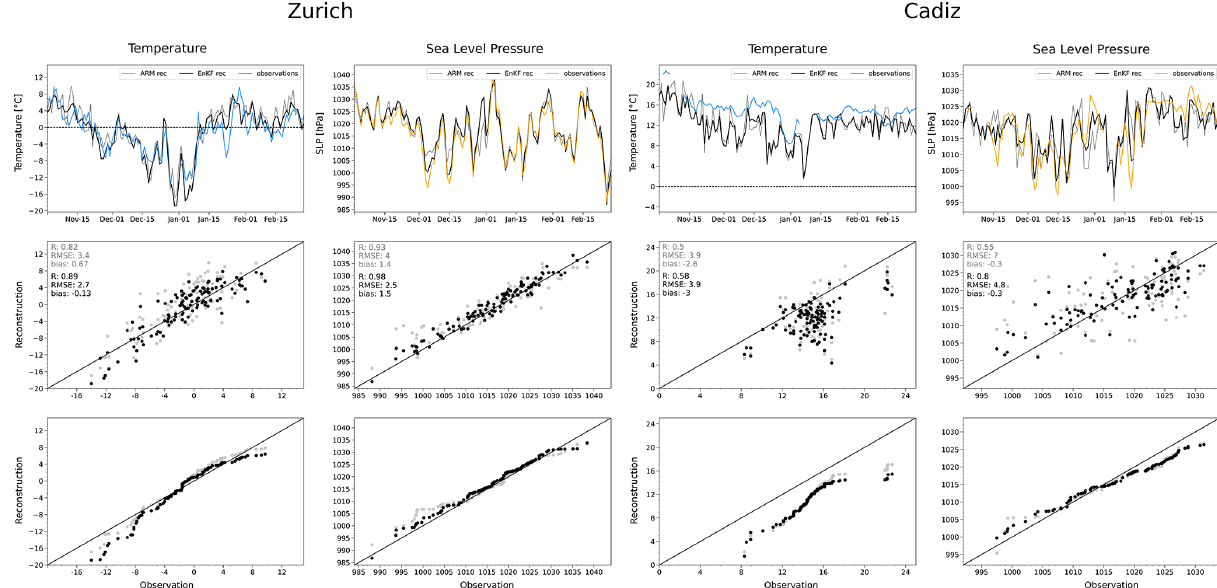
Figure 5. Validation of ARM and EnKF reconstructions of the winter 1788/89 against independent observations from Zurich (left) and Cádiz (right). The top panels show time series of temperature and pressure comparing the ARM (gray), the EnKF (black), and observations (coloured). The panels in the centre are plots of the reconstructions (ARM, gray dots; EnKF black dots) against the observations; the top left corner of the middle panels shows validation metrics for the reconstructions: shown are the Pearson correlation coefficient, RMSE, and bias. The bottom panels are Q–Q plots displaying the